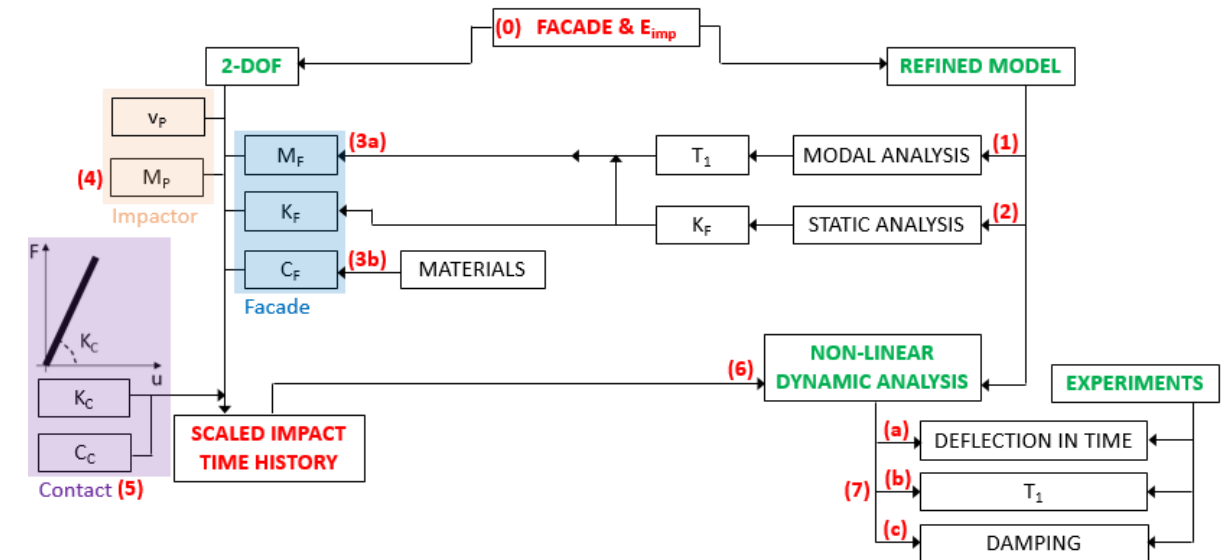
Figure 6. Reference procedural steps for the calibration of input parameters from the herein developed coupled analysis of glass curtain walls under SBI.